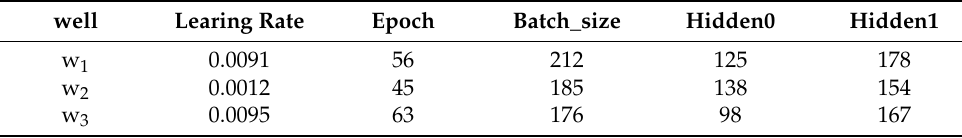
Table 4. Set the final parameters of the